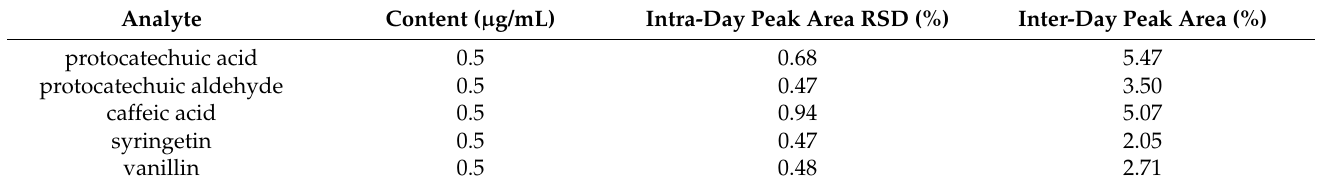
Table 2. Intraday and interday repeatability of the peak area for all analytes (n = 3) by using LVSS- MEKC method.